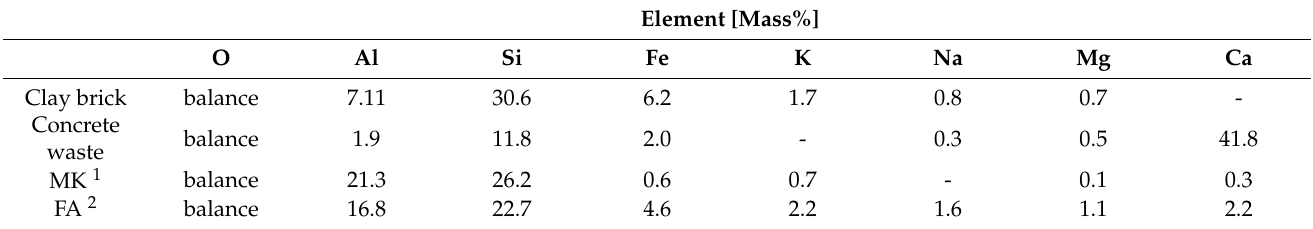
Table 1. Chemical composition of clay bricks and concrete waste.